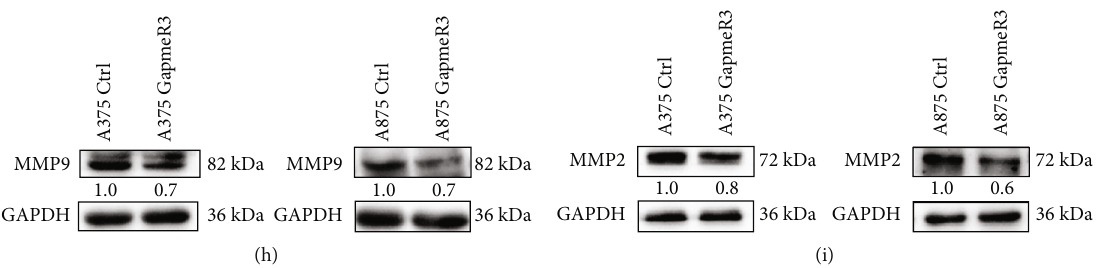
Figure 3: SAMMSON silencing inhibits melanoma cell migration and invasion in vitro . (a, b) Analysis of the e ff ect of SAMMSON knockdown on melanoma cell migration and invasion using Transwell assays. Representative images of migrated and invaded cells are shown in the top panel; quantitative results are shown below the images. (c – g) RT-qPCR analysis of the relative mRNA expression of E-cadherin, vimentin, N-cadherin, MMP9, and MMP2 in SAMMSON-silenced and control melanoma cells. (h, i) Western blotting analysis of the protein expression of MMP9 and MMP2 in SAMMSON-silenced and control melanoma cells. Scale bars = 100 μ m. ∗ p < 0 : 05 , ∗∗ p < 0 : 01 , ∗∗∗ p < 0 : 001 , and ∗∗∗∗ p < 0 : 0001 vs. control in 80.0% (4/5) of cases (Figure 1(d)). In addition, relative